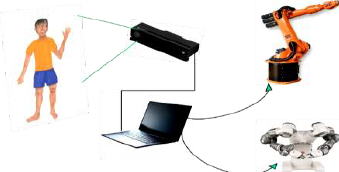
Fig. 9. Proposed further development